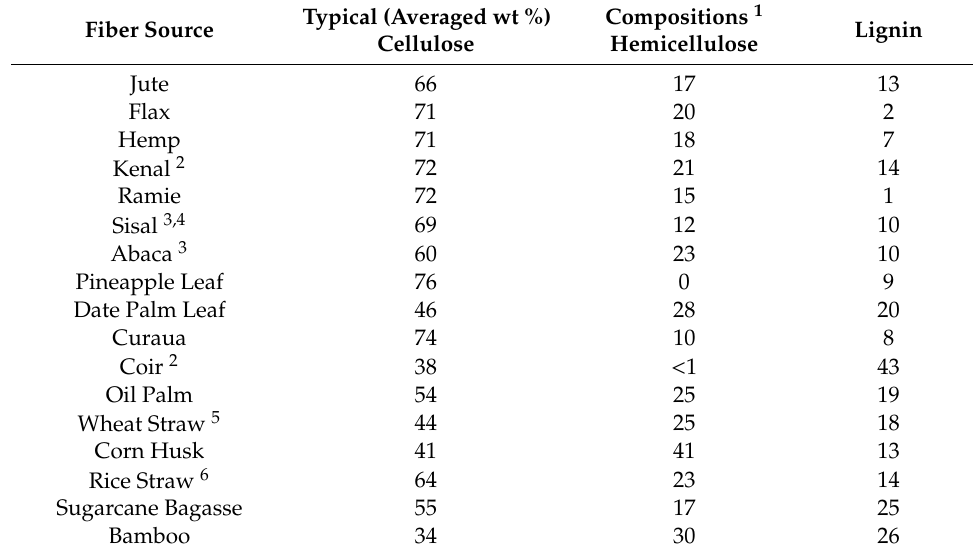
Table 5. Cellulosic fiber compositions [39].